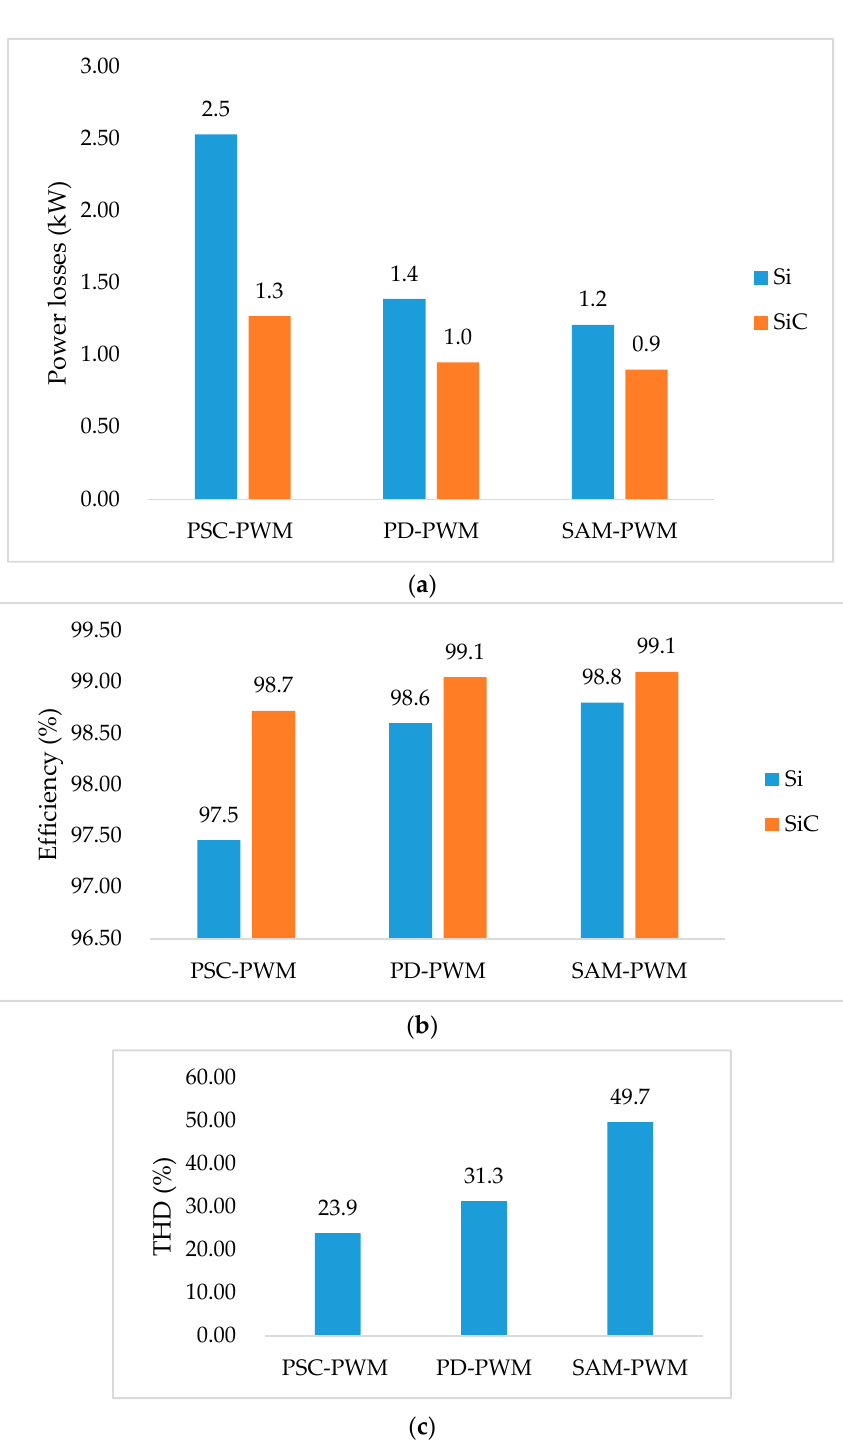
Figure 18. Comparative performance of using Si and SiC semiconductors with different modulation methods and load (100 kW) and input voltage per MMC HBSM (300 V): ( a ) Semiconductor power losses; ( b ) MMC efficiency; ( c ) Output voltage total harmonic distortion (THD).